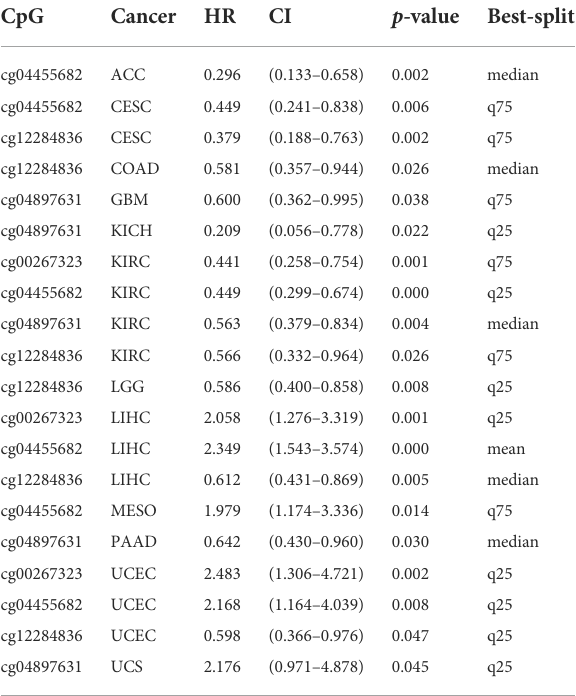
TABLE 1 Effect of hypermethylation level on prognosis in cancer. CpG